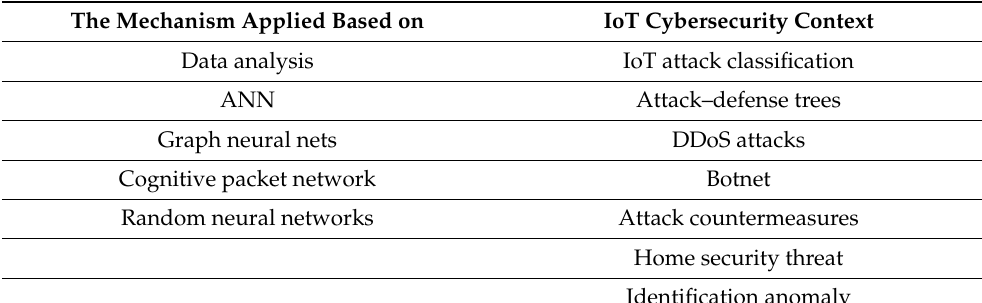
Table 8. Cybersecurity topics related to